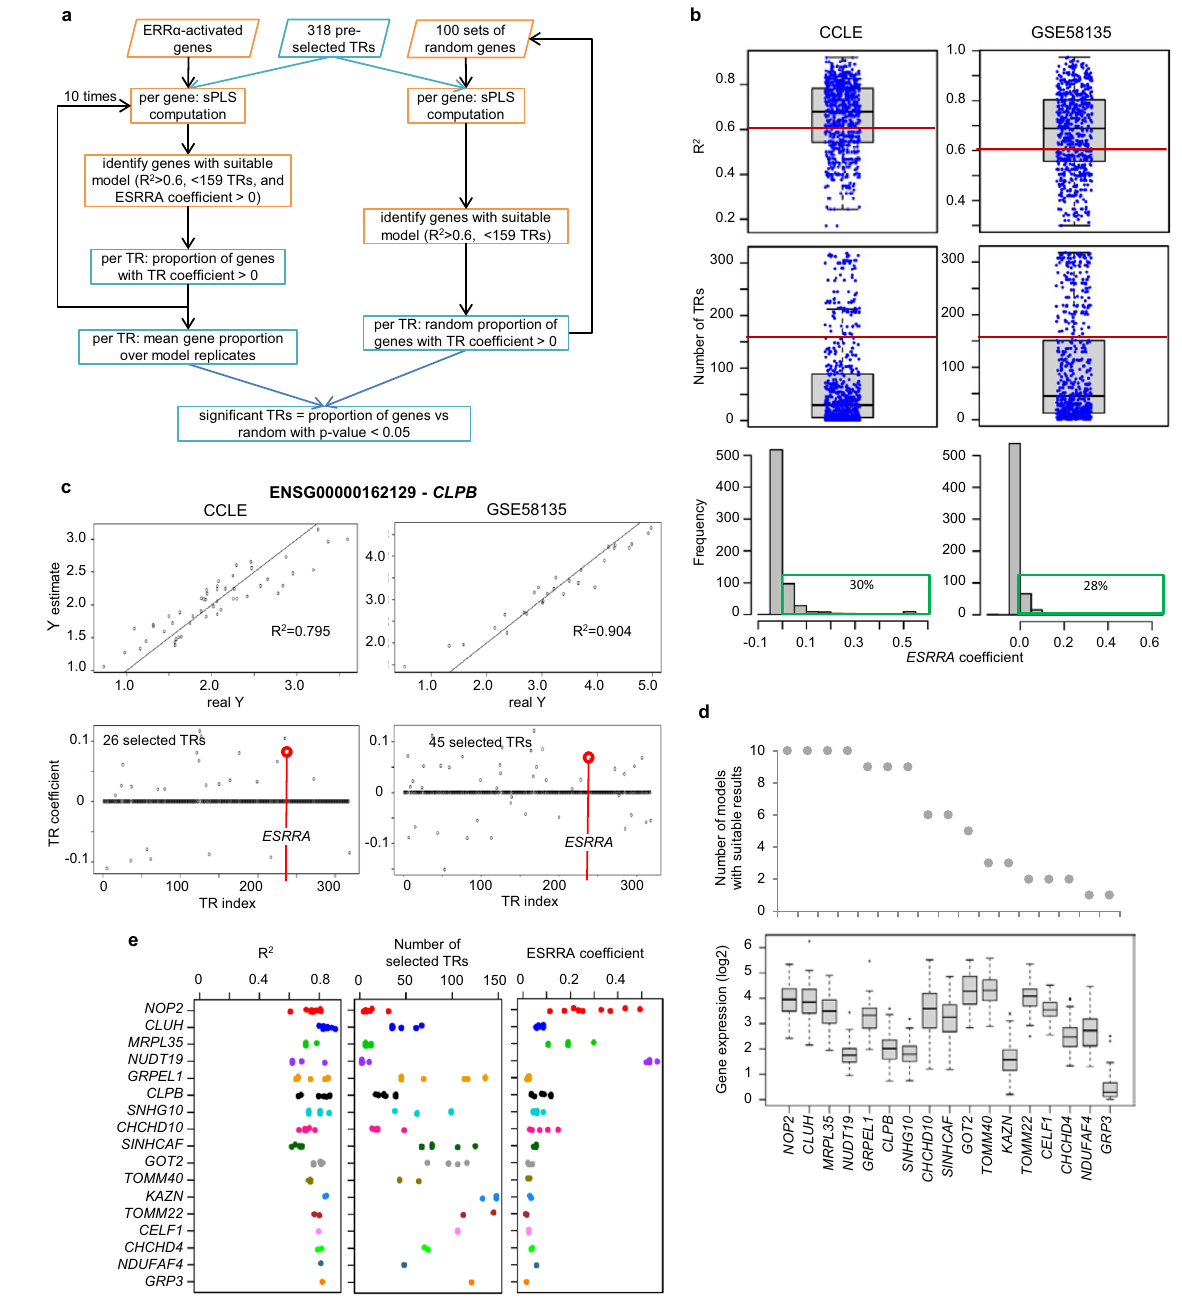
Figure 3. Model features across all ERRα-activated genes and all replicated analyses using two expression datasets. ( a) Flowchart of the modeling procedure used to select TRs. ( b) Boxplots showing individual model R-squared values and the number of TRs selected by the model, i.e. with non-0 coefficient, among 318 ones in each model computed 10 times for 68 and 63 genes with the CCLE and GSE58135 dataset respectively. Red lines indicate the thresholds used for further selection (R2 > 0.6 and number of selected TRs > 159). The lower panel shows histograms of ESRRA coefficient values in models. Most of the values are in the interval ]−0.05, 0] leading to 206/680 (30%) and 177/630 (28%) models including ESRRA with a positive coefficient for CCLE and GSE58135 data respectively. The green rectangles indicate positive ESRRA coefficients. (c) Example of model results for one gene with the two datasets: scatterplots of predicted vs true gene expression and values of TR coefficients given by the model. Data are log2-transformed and the identity line is shown. The TRs selected in one model have non-0 coefficient values and include ESRRA with a positive coefficient. ( d) ERRα-activated genes with suitable expression model in CCLE dataset: number of model replicates giving suitable results and expression of these 17 genes given as boxplot across the 51 breast cancer cells. ( e) Model characteristics across the 10 replicates for the 17 ERRα-activated genes with at least one suitable expression model in CCLE